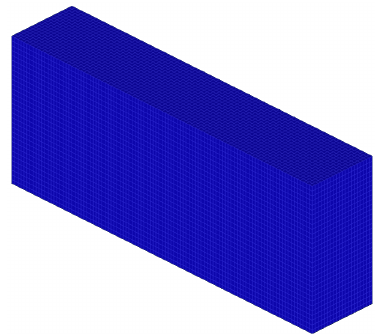
Coatings 2023 , 13 , x FOR PEER REVIEW Figure 3. Finite element grid view for the polymer sample without sputtering. Figure 3. Finite element grid view for the polymer sample without sputtering.